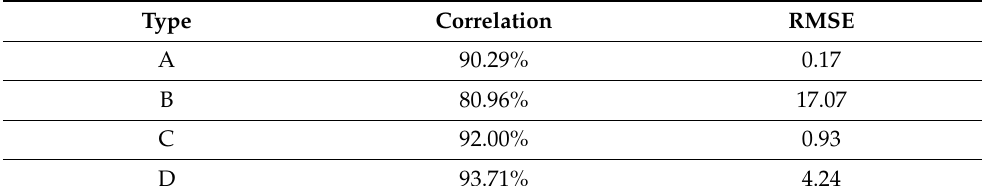
Table 6. Performance of the optimal LSTM model (training dataset).